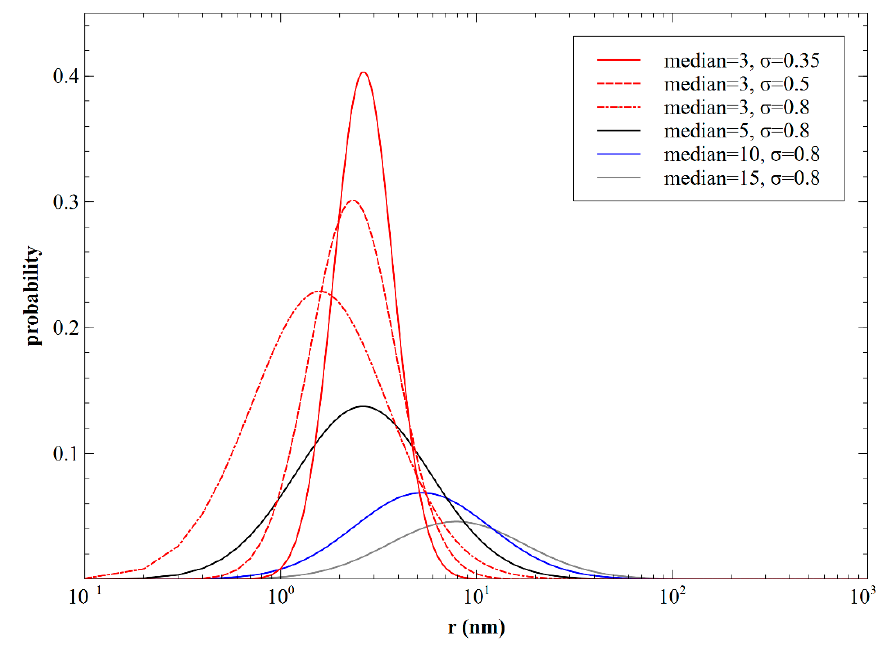
Figure 9. Pore size distribution with different median and logarithmic standard deviation.